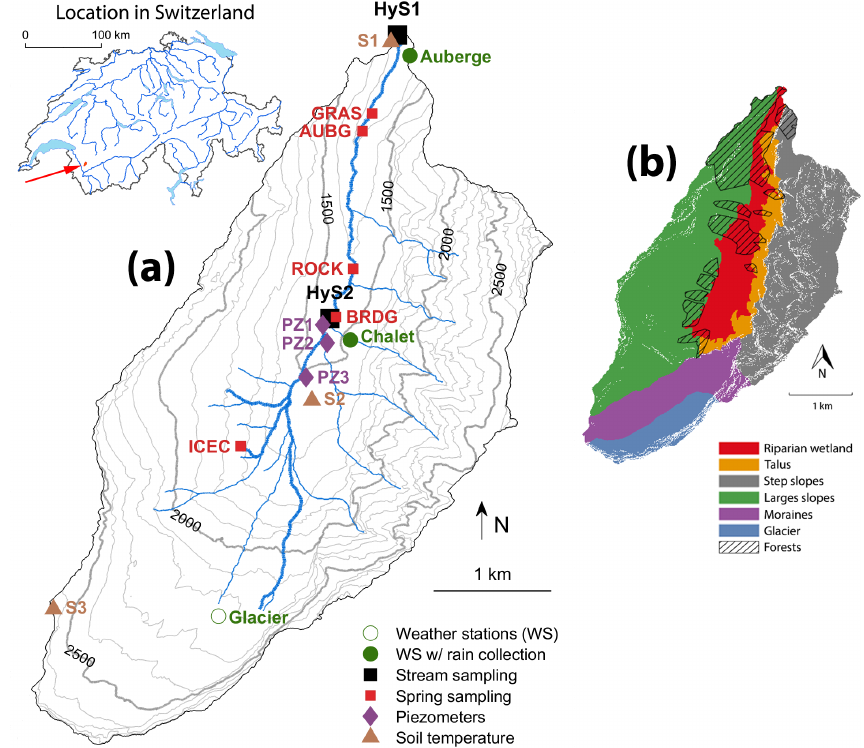
Figure 1. The map in panel (a) , based on the 2m digital elevation model (Swissalti3d, 2012), shows the location of the sampling sites in the Vallon de Nant (outlet at 46.25301 ◦ N, 7.10954 ◦ E in WGS84; elevation 1200ma.s.l.). The list of locations is given in Table S1 in the Supplement. The locations of other springs are also shown in red with four-letter identifiers (GRAS for grassy spring; ROCK for rocky spring; BRDG for spring under the bridge; ICEC for icy curve spring). The piezometers are marked in purple with numbers following PZ, and the locations of soil temperature measurements are shown in brown with the abbreviation of S followed by a number. The two stream sampling locations are the two hydrostations (HyS1 and HyS2) shown in black. The stream network shows the full extent, which is only during snowmelt periods. The Auberge (AUBG) spring location shows where the water is sourced from, even though it is sampled from a pipe at the Auberge weather station point 800m further north. The map in panel (b) identifies the dominant hydrological units of the Vallon de Nant and the hatched area corresponds to forested